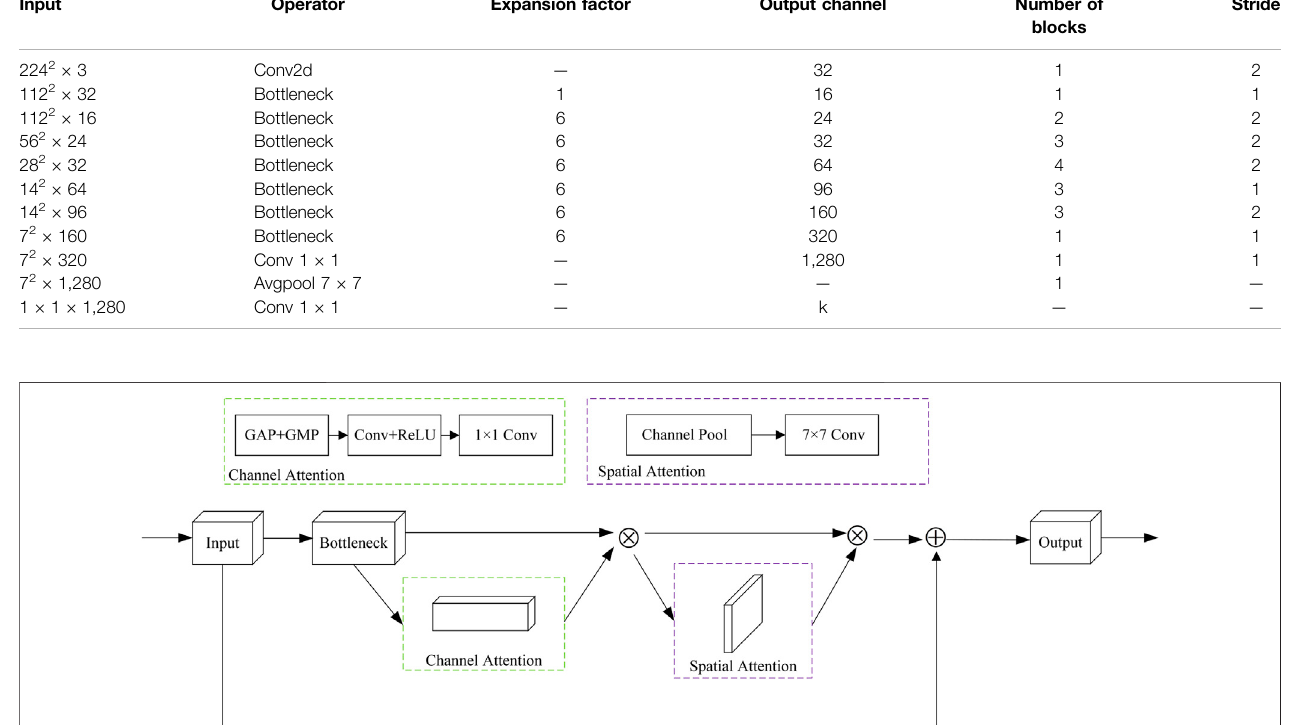
FIGURE 4 | Structure diagram of Backbone optimized based on dual attention